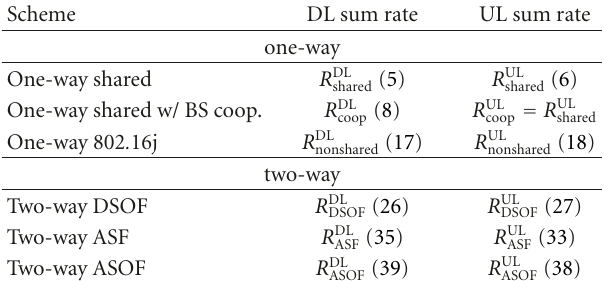
Table 3: Sum rate references for proposed